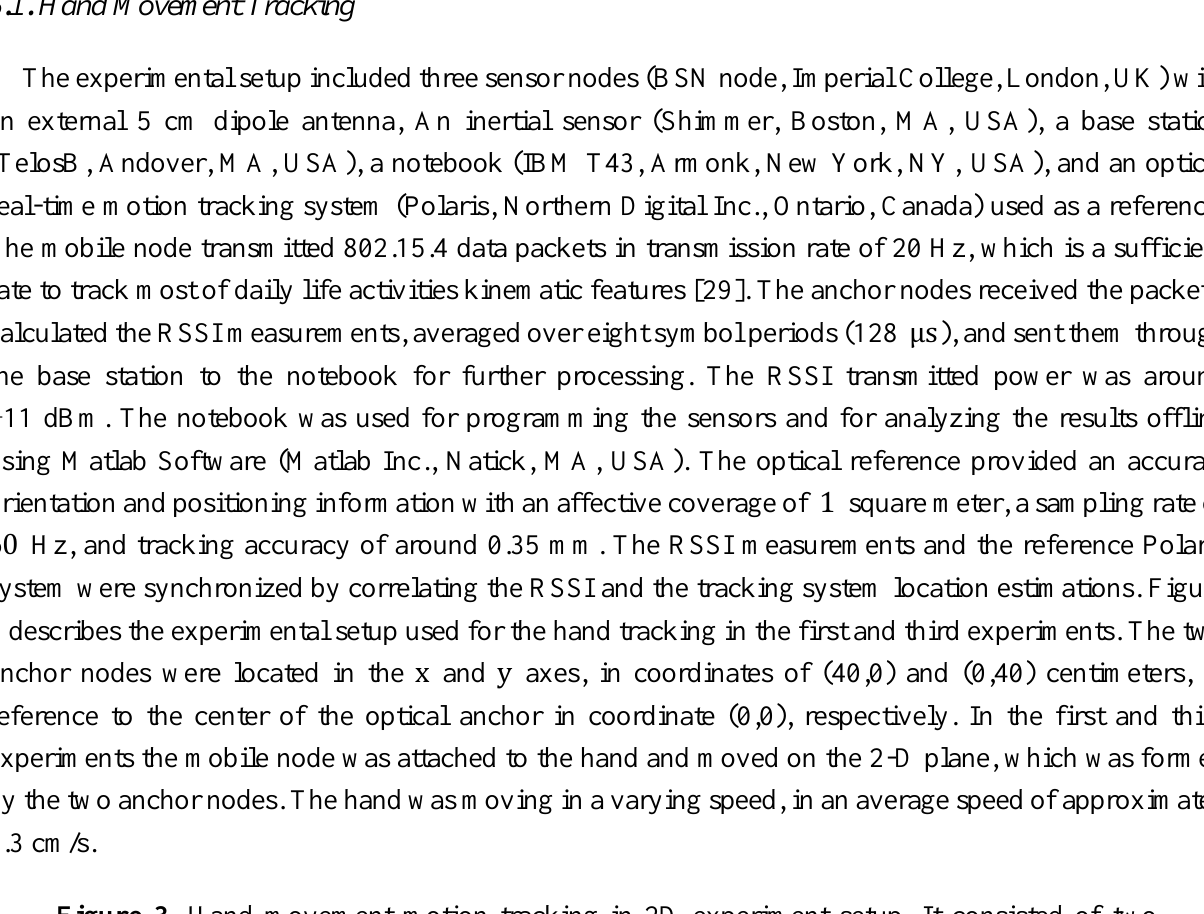
Figure 3. Hand movement motion tracking in 2D experiment setup. It consisted of two anchor nodes (BSN), located at x and y axes, a mobile node attached to a hand (BSN), an inertial sensor (Shimmer), used for sensor aggregation, and a reference Optical Sensor